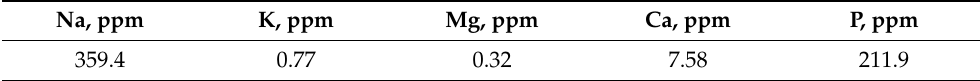
Table 1. Average mineral composition of raw caseinate solution.